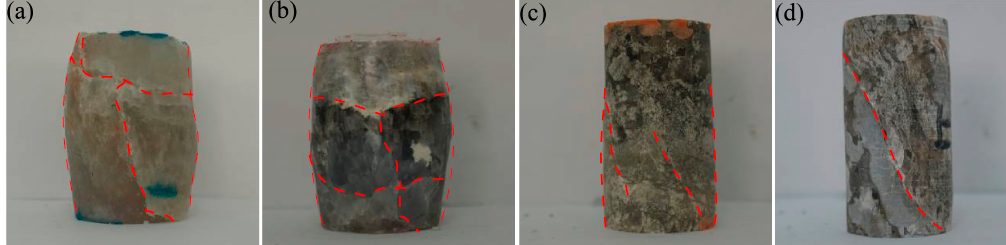
Figure 9. Salt rock specimens after failure. ( a ) ω = 3.00% (SR-1); ( b ) ω = 13.07% (SR-2); ( c ) ω = 39.16% (SR-3); ( d ) ω = 60.02% (SR-4).